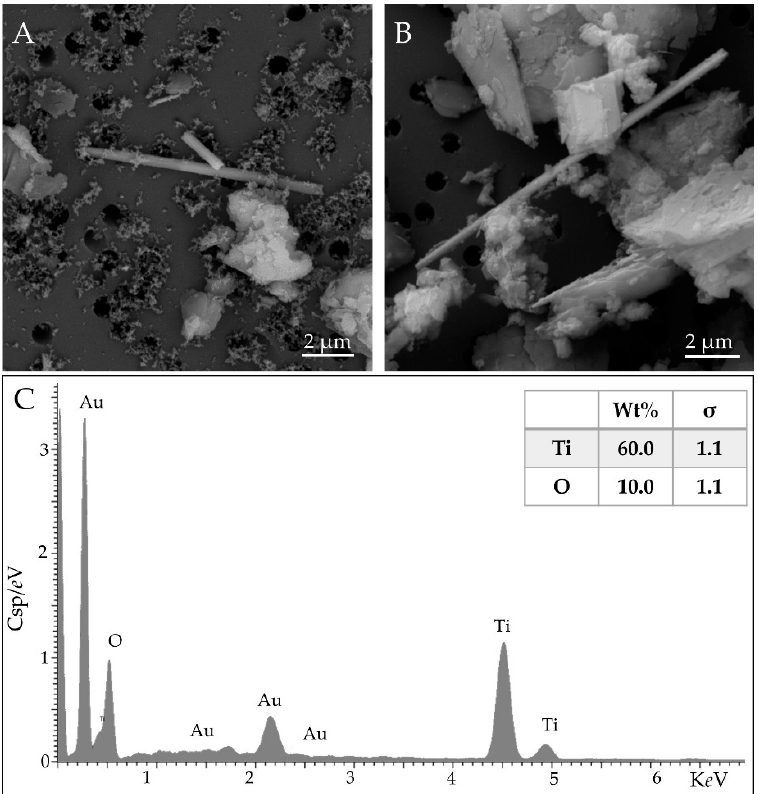
Figure 1. Detail of airborne rutile fibers in shale sample at 20,000 × ( A , B ) and the representative elemental analysis ( C ). The results are shown as weight percentage (Wt%). The statistical error is displayed as sigma ( σ ), representing the overall confidence figure for the analysis, especially when an element is present at a low concentration. Scale bar in microphotographs; High Vacuum: 20 kV; Detector: Back Scattered Electrons and Energy Dispersive